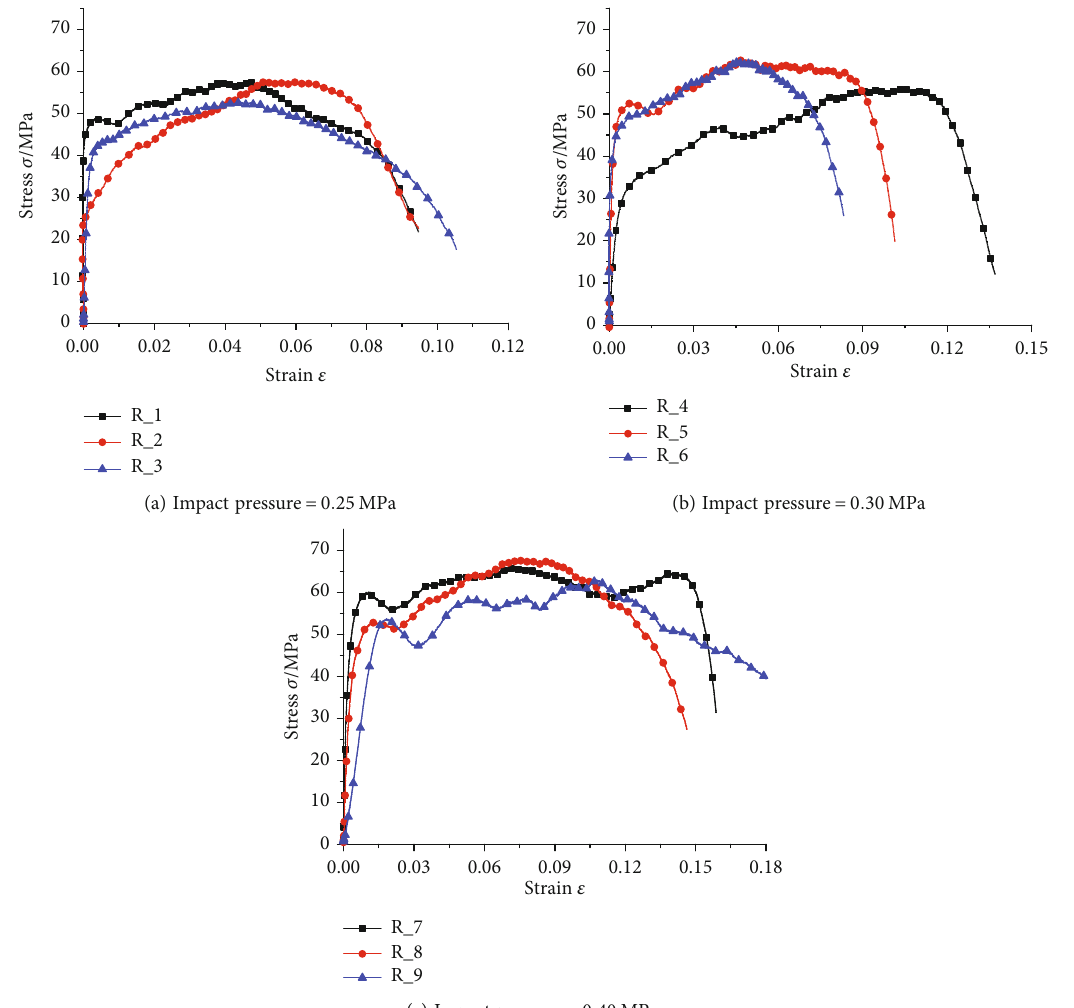
Figure 9: Dynamic stress-strain curves of mudstone specimens under di ff erent impact loadings.